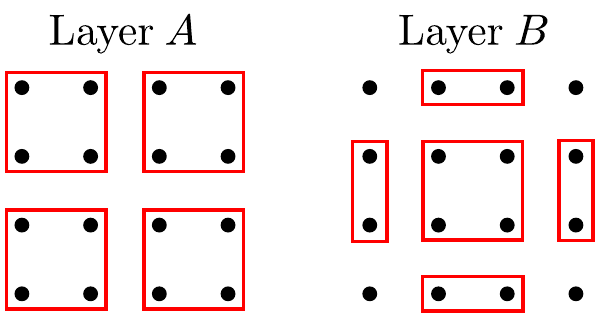
FIG. 9. Two-dimensional hardware-efficient ansatz used in this work to simulate the N 2 molecule in the STO-3G basis (16 qubits).